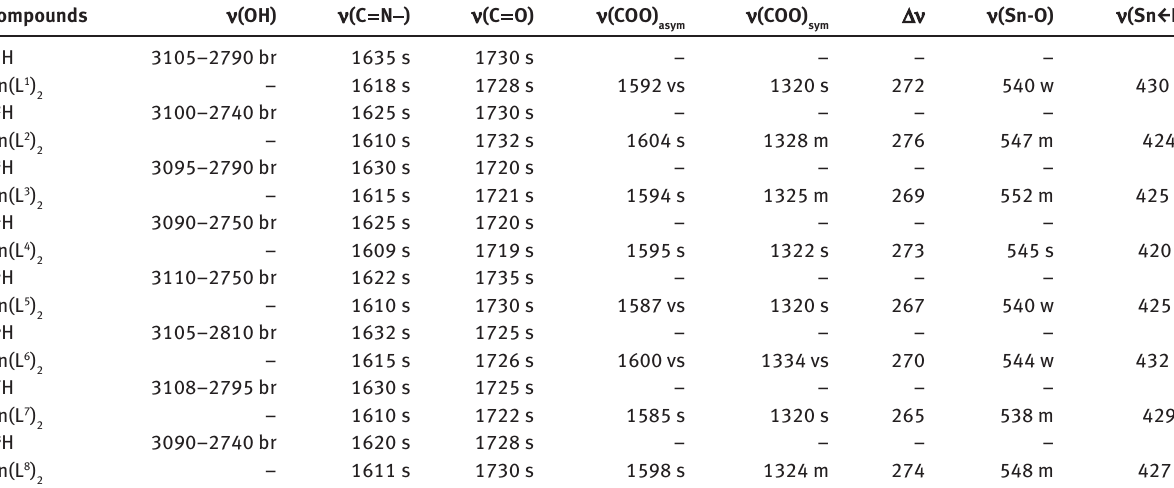
Table 2: Important IR spectral data (cm –1 ) of Schiff bases and their corresponding tin(II) complexes.